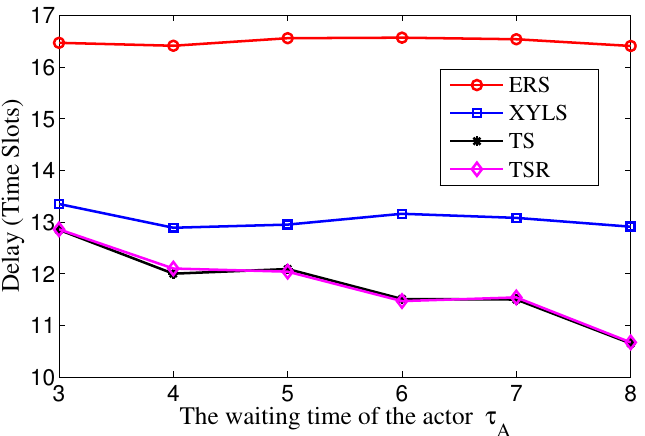
Figure 13. The search delay over the waiting time of actor τ A